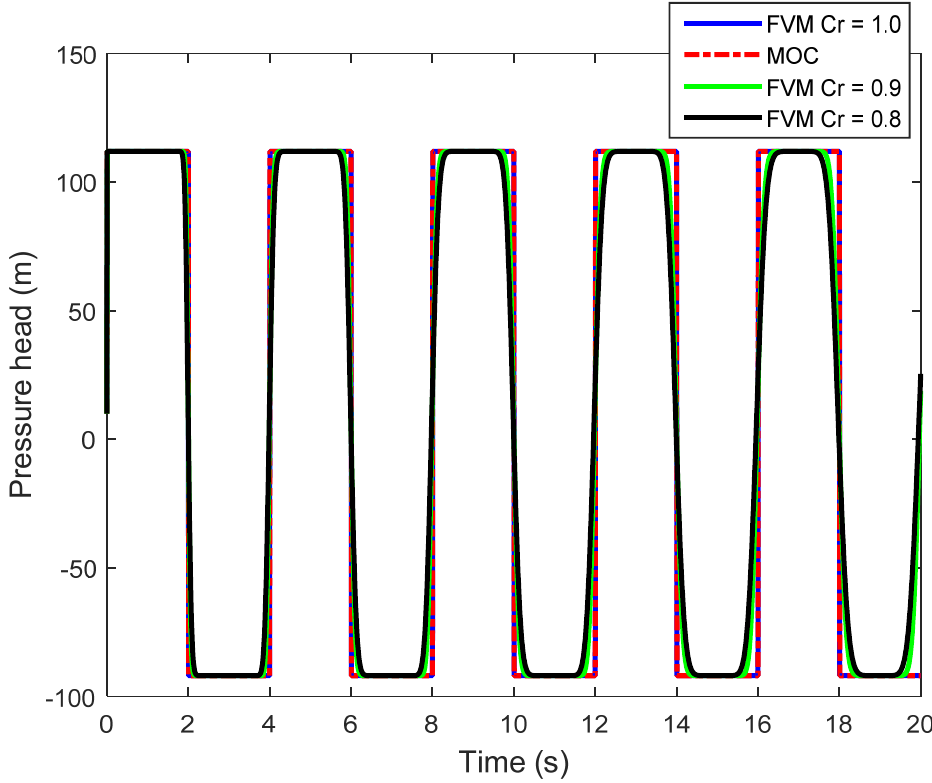
Figure 14. Comparison between the FVM, with different Courant numbers, and the MOC.